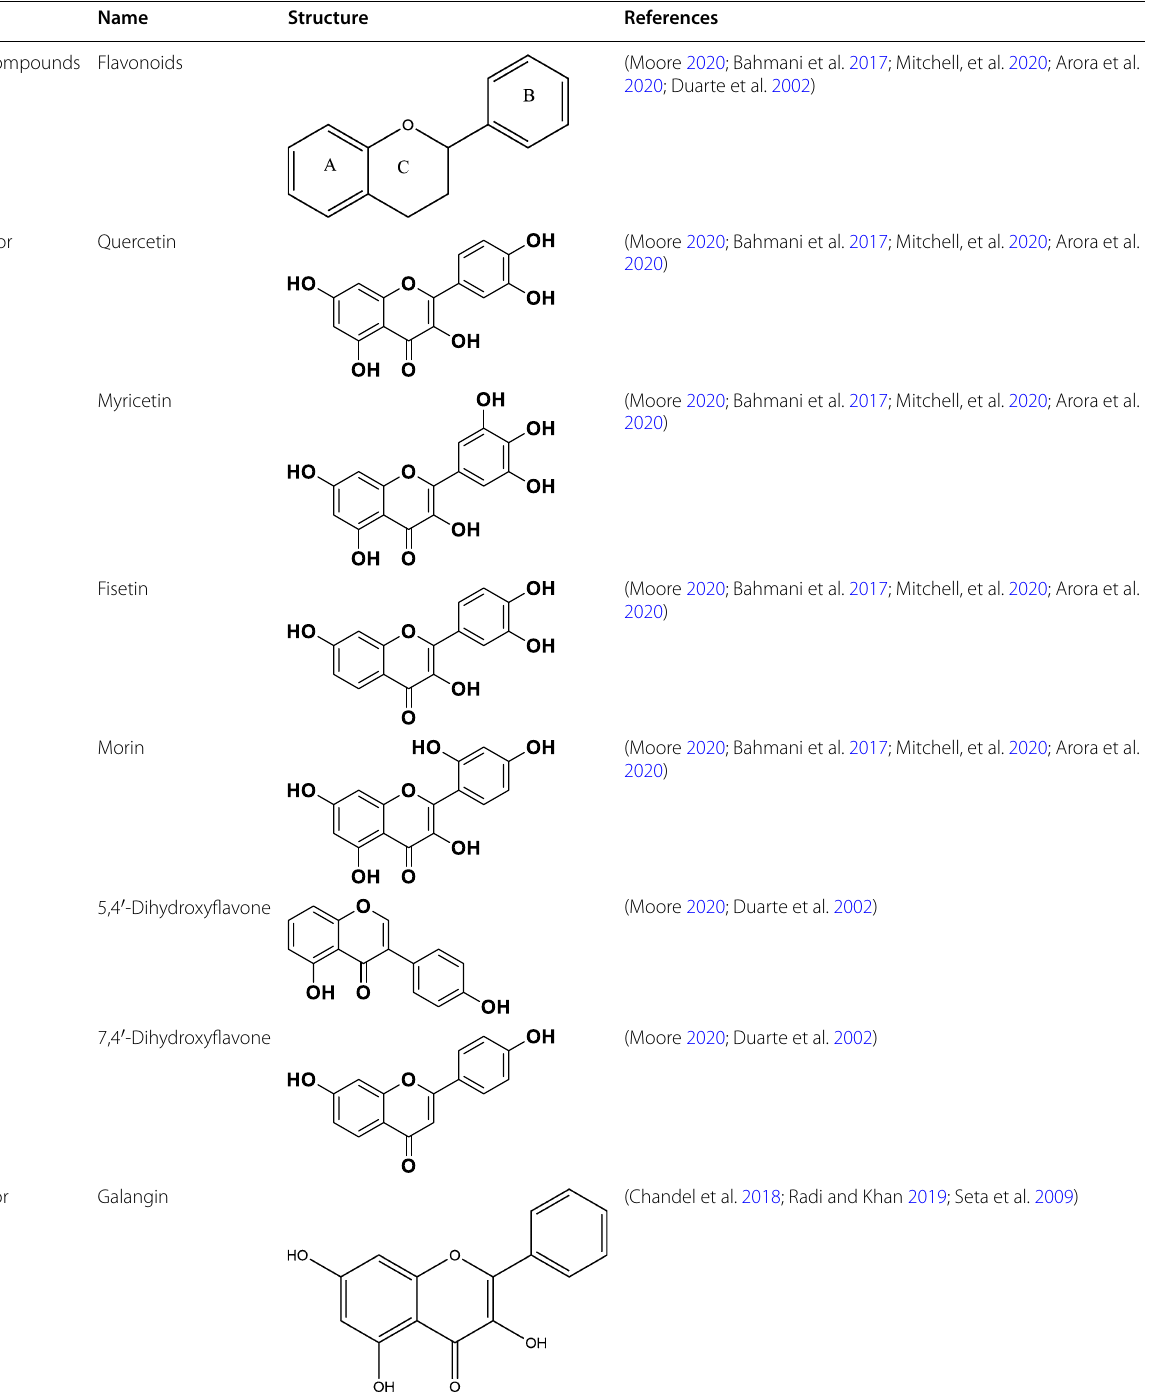
Table 1 Chemical structures of quercetin-like natural plant compounds as cofactors of